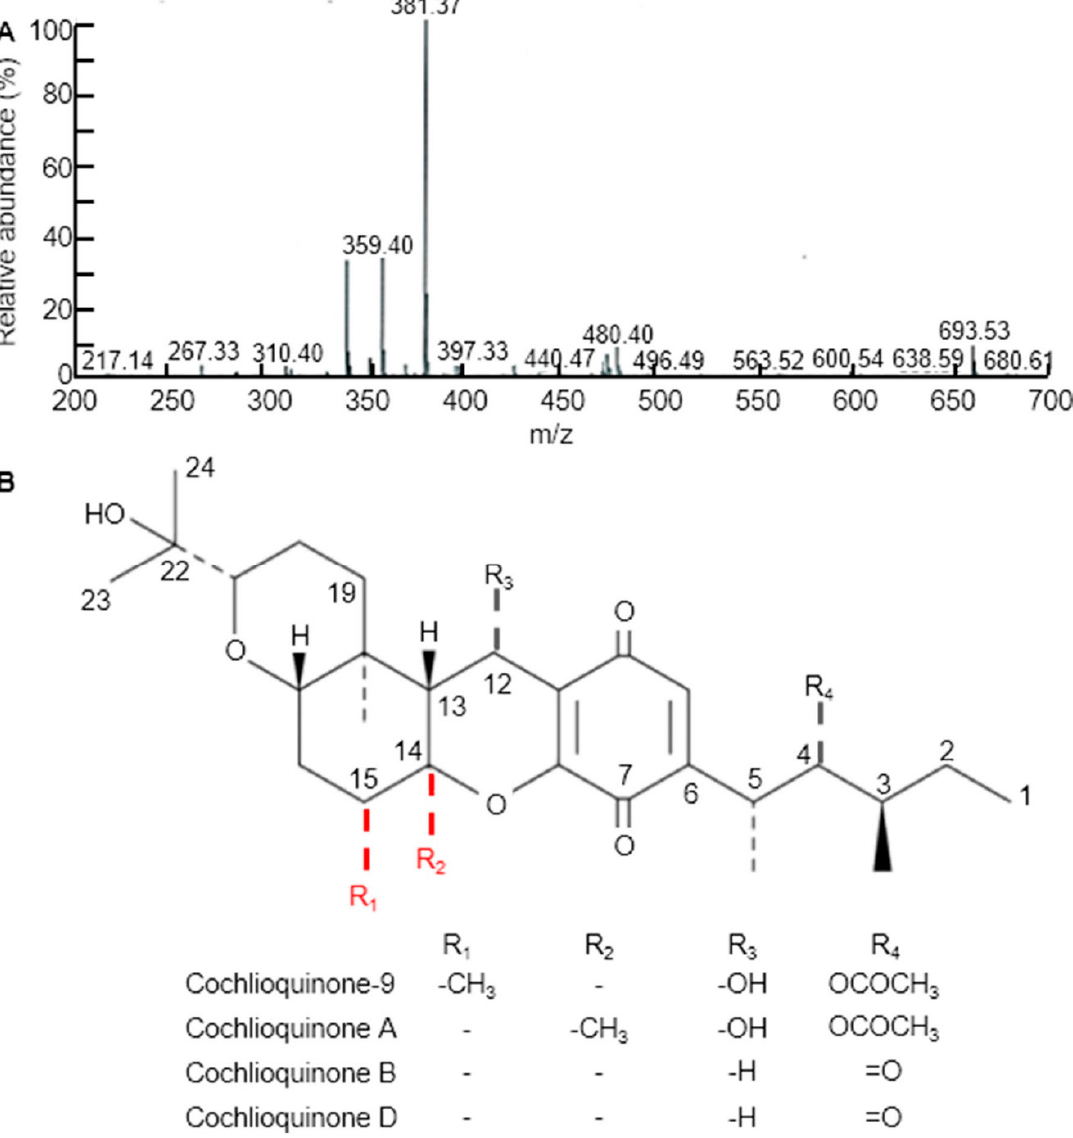
Figure 2. Extraction of substances related to Cochlioquinone-9 (cq-9). ( A ) Molecular weight of cq-9. Mass: 381.38. ( B ) Chemical structure of cq-9; (3R)-9-[(1S,2R,3S)-2-acetyloxy-1,3-dimethylpentyl] 1,2,3,4a,5,6,6a,12,12a,12b-decahydro-12-hydroxy-3-(1-hydroxy-1-methylethyl)-6a,12b-dimethylpyrano[3,2-a]xanthene-8,11-dione, C 30 H 44 O 8 , molecular weight = 532.7 g/mol.